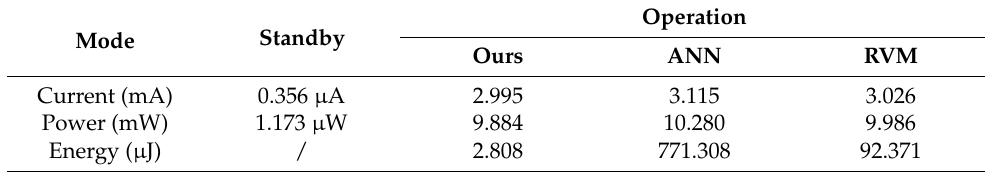
Table 14. Power and energy consumption of Self-Detection and Self-Calibration on CC1350. Mode